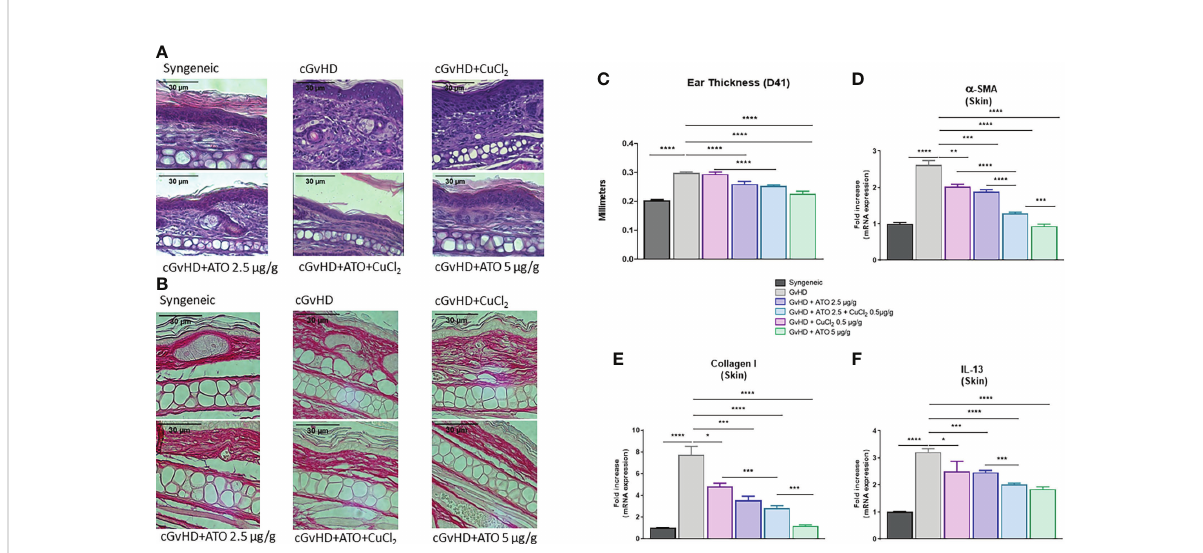
FIGURE 5 ATO and Cu 2+ reduce skin fi brosis. (A) Hematoxylin and eosin (H&E) staining of ear skin sections (5 m m) (Eclipse 80i microscope; Nikon, original magni fi cation ×20). Skin was disordered, with abundant in fi ltration of in fl ammatory cells and thickening (presentation of the 6 different groups of cGvHD mice). (B) Sirius red staining of ear skin sections (5 m m) (Eclipse 80i microscope; Nikon, original magni fi cation ×20). Skin was fi lled with a collagen deposit. (Presentation of the 6 different groups of cGvHD mice). (C) Ear thickness of the different groups of cGvHD mice. The thickness of the ears was assessed weekly. Differences between groups were assessed at day 41, one day before sacri fi ce, to allow time for cGvHD to develop. (D – F) Relative mRNA expression of a -SMA , collagen I and IL-13 in the skin of the ears. Data are presented as 2 ( − DD CT) relative to the levels of GAPDH . *p <0.05; **p<0.01; ***p<0.001; ****p<0.0001. The results for each group are the mean of the measurements obtained per mouse: syngeneic (n = 7); cGvHD (n = 10); cGvHD-Cu (n = 6); cGvHD-ATO 2.5 µg/g (n = 8); cGvHD-ATO-Cu (n = 11); cGvHD-ATO 5 µg/g (n = 5). Ex vivo measurements were realized in duplicate for each